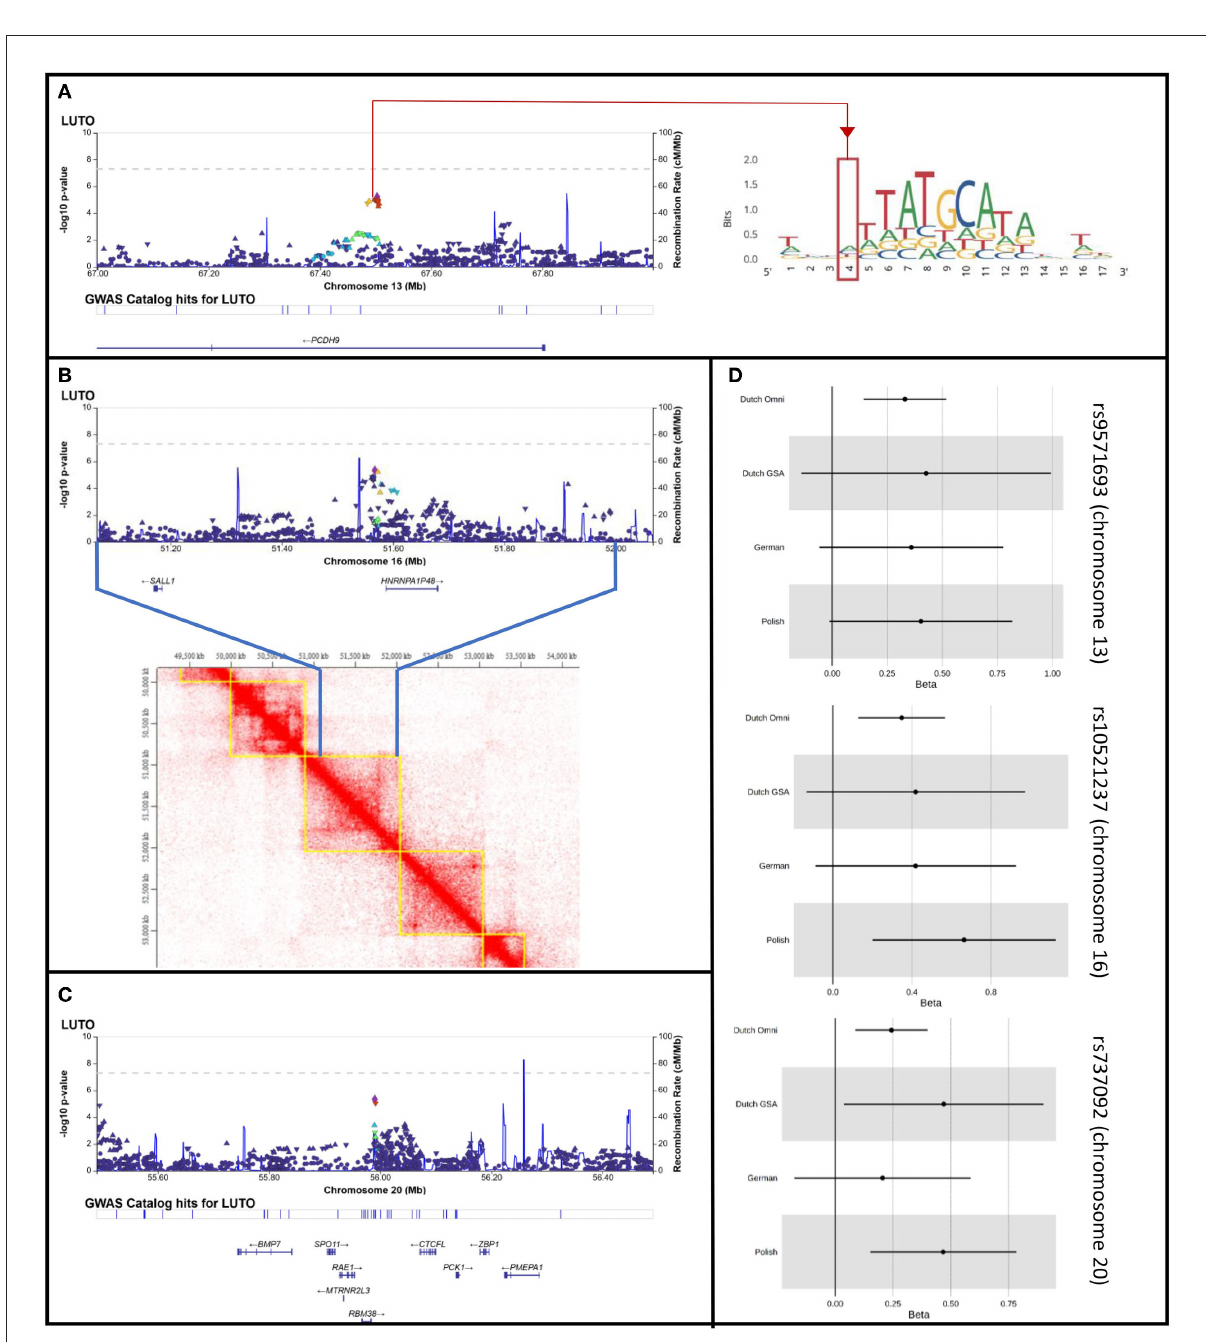
FIGURE2 LocusZoom plots for the loci on chromosome 13, 16, and 20 with multiple variants residing within < 10kB of each other showing suggestive significance ( P < 1 × 10 − 5 ) and with the same effect direction in all 4 cohorts. (A) Locus Zoom plot for chr. 13, with LD scoring referring to top SNP rs9571693. Red line and red quarter indicate rs34844007 in locus zoom plot and in position weight matrix ENCFF525TXJ targeted by POU class family genes. (B) Locus Zoom plot for chr. 16, with LD scoring referring to top SNP rs10521237. Heat map visualization of Hi-C interactions among parts of Chr.16q12.1 and parts of 16q12.2 from HMEC human kidney cells, as plotted by TADKB. Blue lines indicate the region plotted in the locus zoom, showing the identified locus and SALL1 to locate in the same topological associated domain. (C) Locus Zoom plot for chr. 20, with LD scoring referring to top SNP rs737092. (D) Forest plots for rs9571693, rs10521237, and rs737092, the leading SNPs of the loci on chromosome 13, 16, and 20,